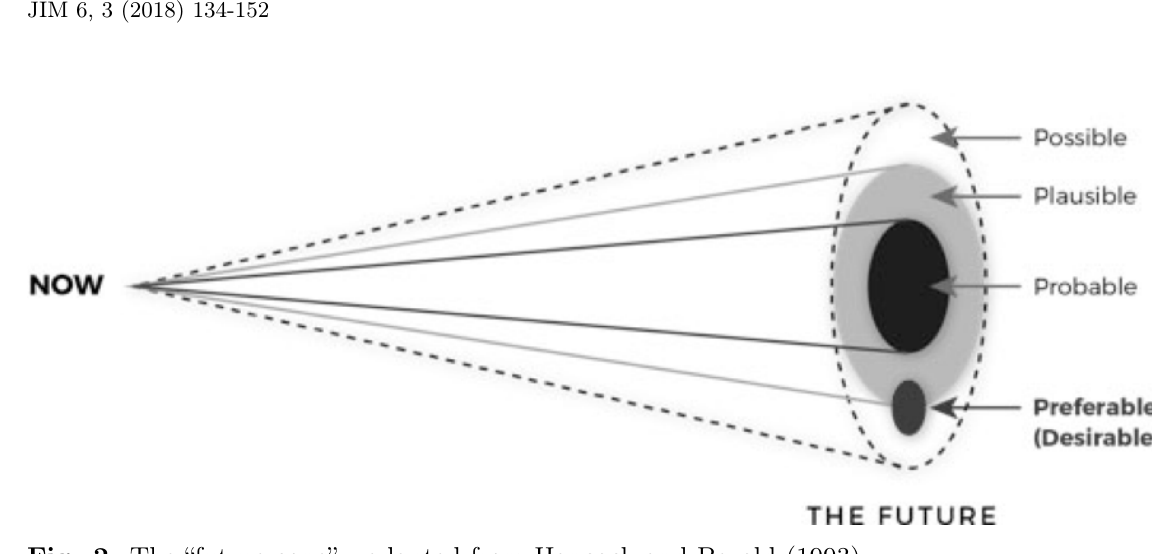
Fig. 2. The “future cone” - adapted from Hancock and Bezold